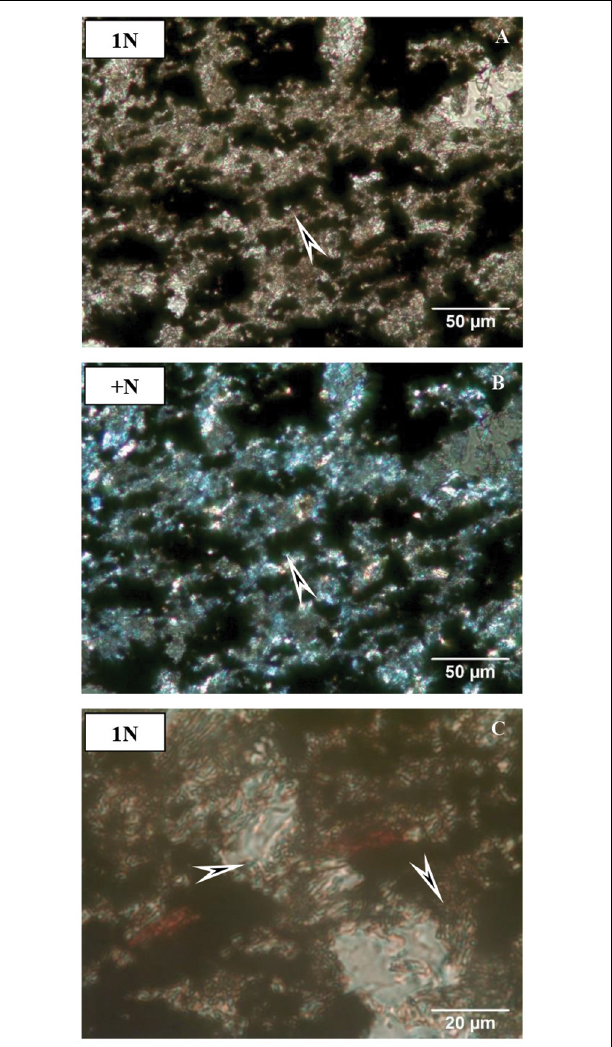
FIGURE 3 | Microtextural features of samples by optical rock microscopy (OM). Mineralized microbial biosignatures (arrows). (A) Sample COR-7. (B) Sample COR-10. (C) sample COR-31 (transmitted light, 1 N).